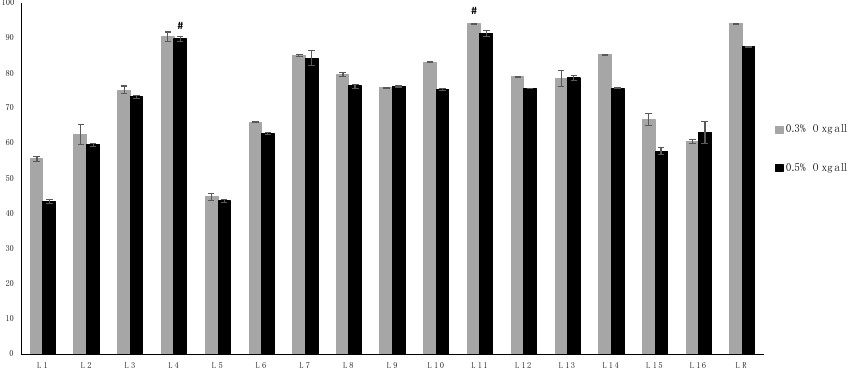
Figure 3. Survival rates of lactic acid bacteria after 4 h of exposure to MRS broth supplemented with Oxgall. (Isolate code: L1–L16: Leuconostoc mesenteroides subsp. mesenteroides, LR: Lactobacillus reuteri Protectis DSM17938). The results are expressed as a mean ± SD of three independent experiments. Data points denoted with a # bear no statistically significant difference to LR.